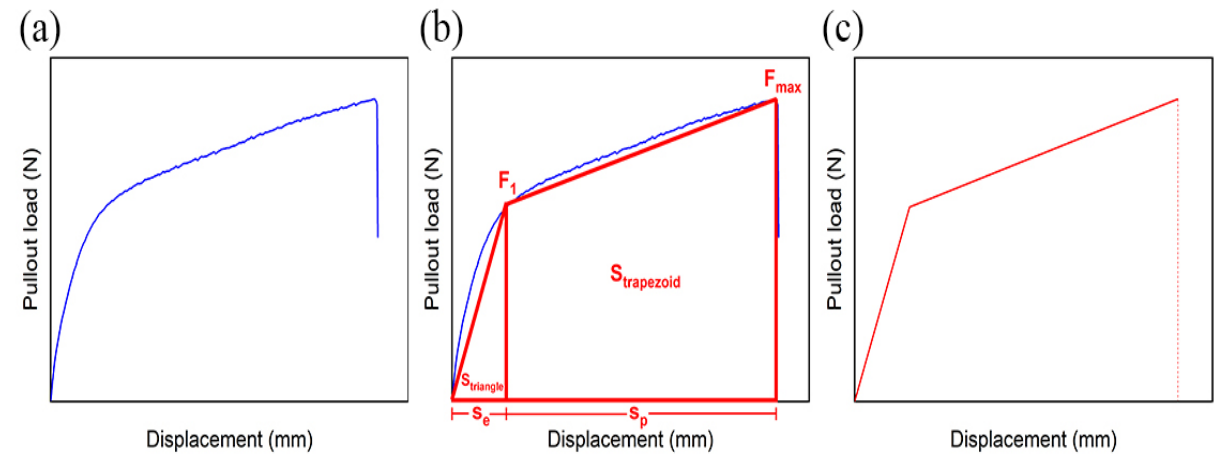
Figure 3. ( a ) Approximate shape of load–displacement curve obtained in the test, ( b ) estimation method of load–displacement curve, and ( c ) approximate shape of load–displacement curve obtained after estimation.